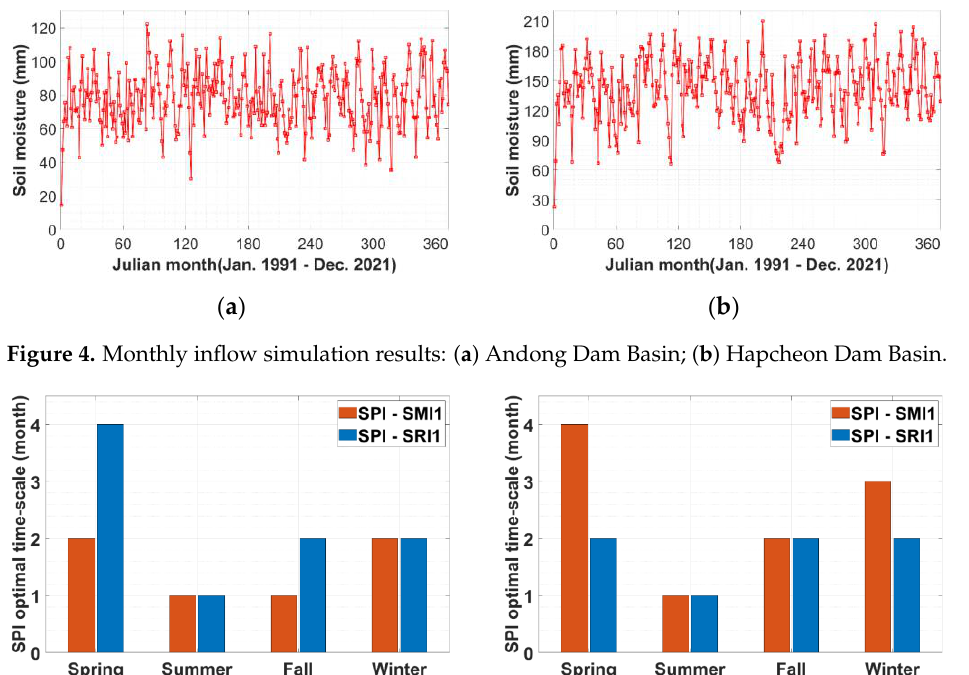
Figure 4. Monthly inflow simulation results: ( a ) Andong Dam Basin; ( b ) Hapcheon Dam Basin.